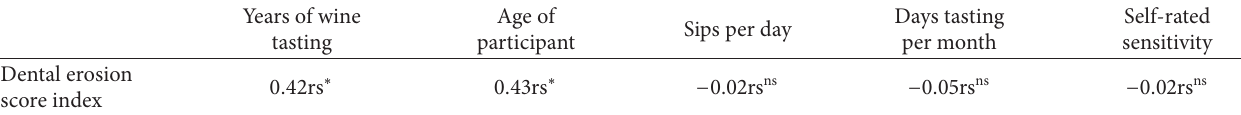
Table 1: The correlation coefficient (rs) and significance ( ∗ 𝑃 < 0.05 , ns: not significant) between dental erosion and self-rated sensitivity, age, years of wine tasting, and wine sips per day and month.